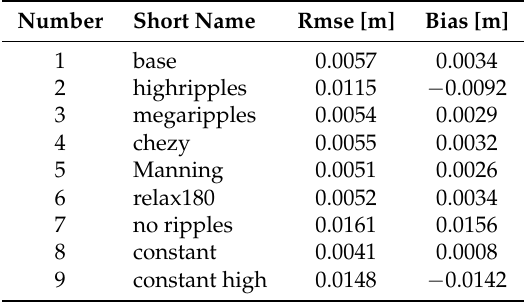
Table 3. Root-mean-square error and bias between the modelled and measured ripple roughness (meas-mod), averaged over all